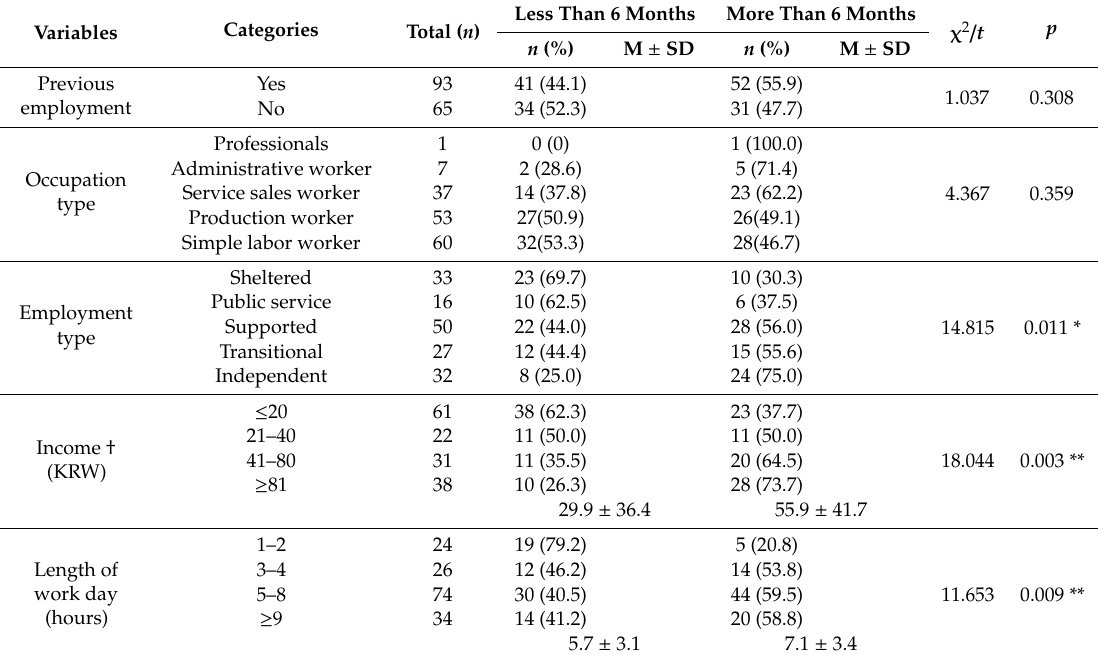
Table 3. Participants’ vocational characteristics.